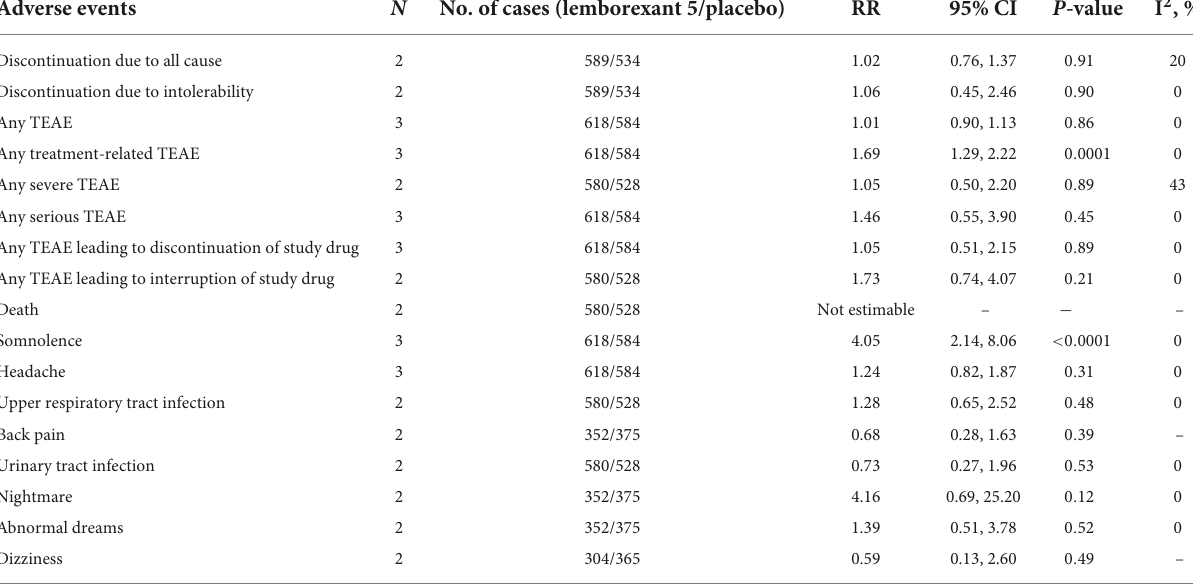
TABLE 7 Treatment discontinuation and individual adverse events for lemborexant 5 vs. placebo. Adverse events N No. of cases (lemborexant 5/placebo) RR 95% CI P